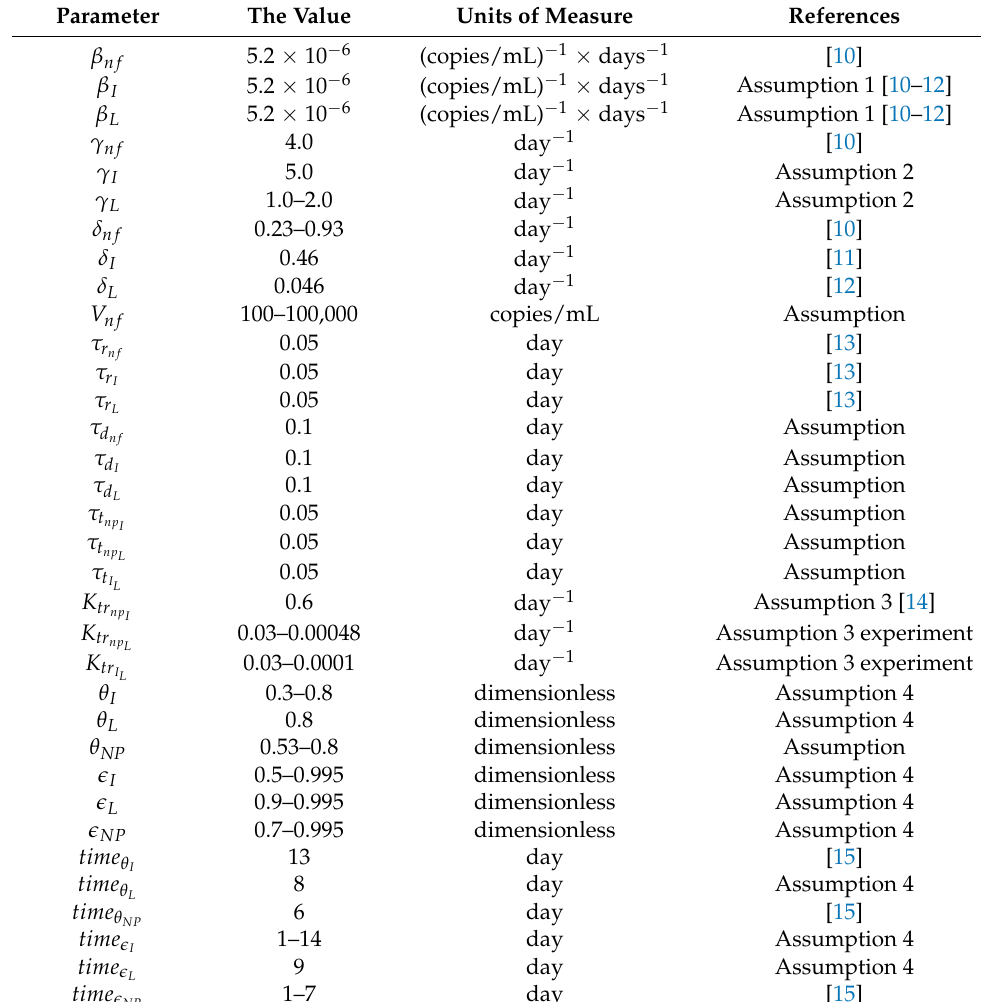
Table 1. Kinetic parameters of the modular model of SARS-CoV-2 infection and distribution between the three